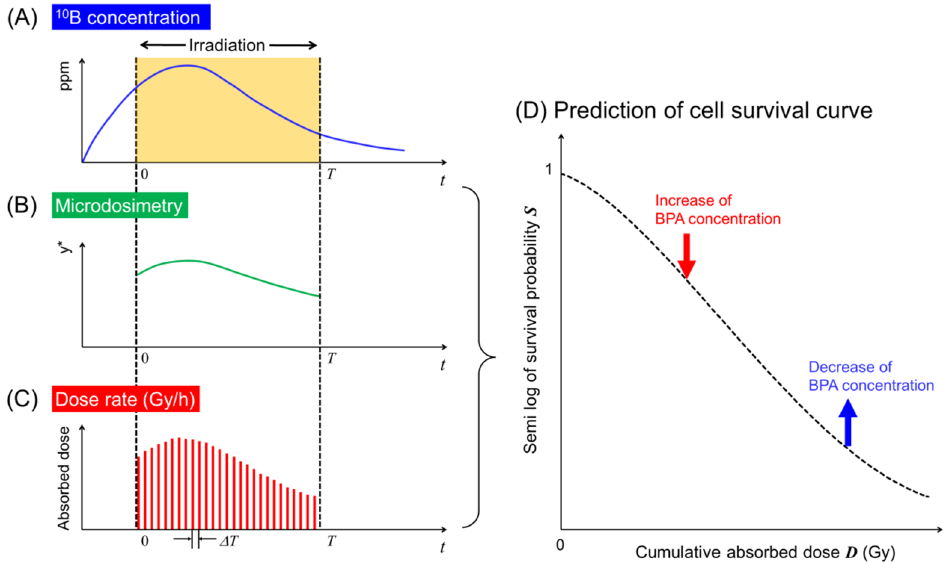
Figure 1. Schematic representation of the timeline of 10 B concentrations incorporated into the IMK model: ( A ) timeline of the concentration of 10 B in ppm; ( B ) change of microdosimetric quantity; ( C ) change of dose rate; ( D ) dose-response curve considering changes of microdosimetry and dose rate depending on 10 B concentration during irradiation. During the course of the irradiation, the concentration of BPA labeled with 10 B, the microdosimetric quantity and the absorbed dose-rate can be determined by the PHITS calculation. Using the changes in both y* and the absorbed dose per sub-interval of dose-delivery time Δ T (i.e., [0, Δ T ], [ Δ T , 2 Δ T ], …, [( N － 1) Δ T , N Δ T ]), the cell survival curve can be described by the IMK model.